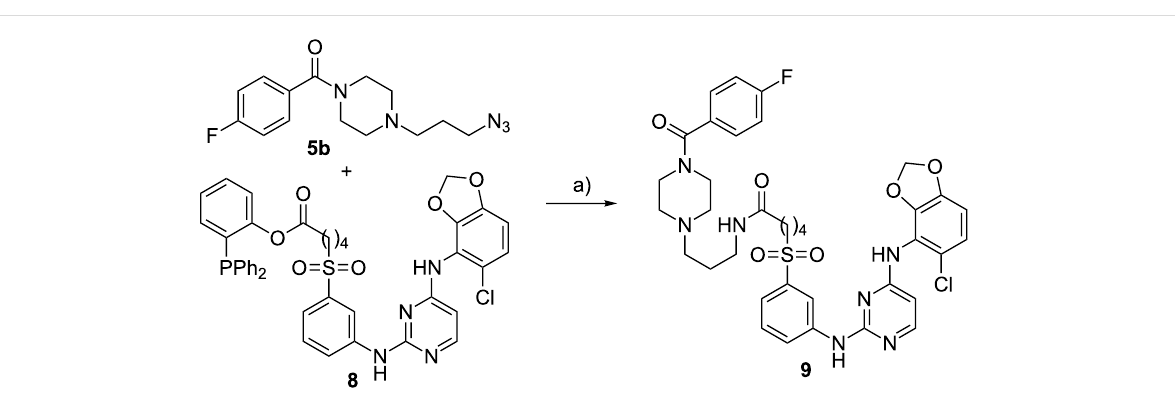
Scheme 3: The traceless Staudinger ligation to yield compound 9 . Reagents and conditions: a) acetonitrile/water 10:1 (v/v), 60 °C, 3 h.